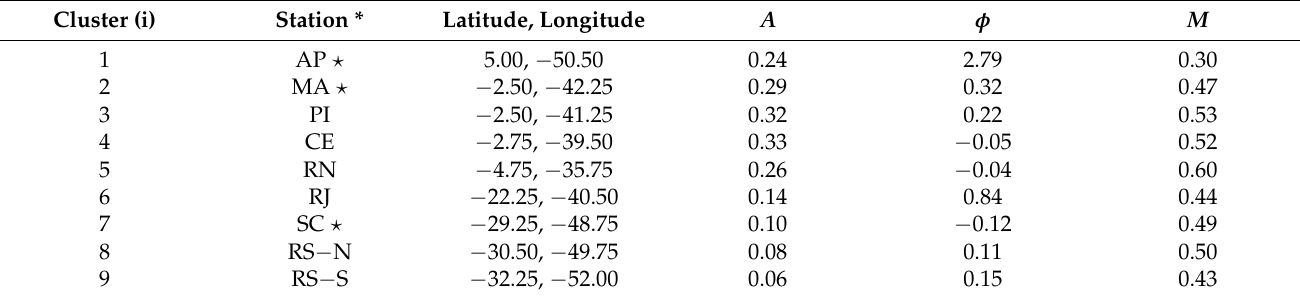
Table 1. Offshore stations selected for analysis, numbered from i = 1 to 9 (cluster). Stations’ latitudes and longitudes are indicated. A represents the amplitude, φ the phase (rad), and M the average capacity factor, with these parameters obtained by adjusting a harmonic of 365 days period to each capacity factor time series (see Equation (2)). Capacity factors are computed from 30 years of ERA5 wind time series and application of a modern turbine power curve. All stations refer to wind farm clusters currently under environmental licensing at IBAMA, except for those indicated with a star (cid:63) (see Figure